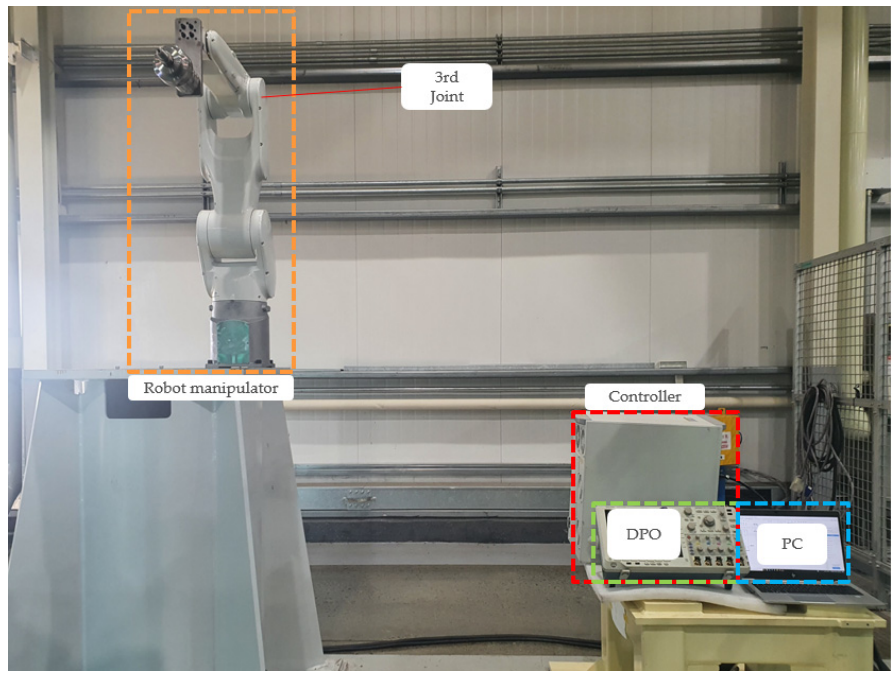
Figure 4. Experimental setup for the HYUNDAI HH7 manipulator and Hi5a-T10 controller. Table 2. Specification of the control cable.